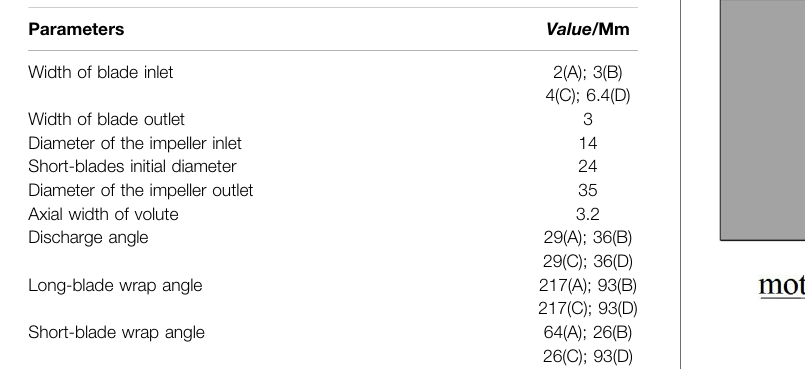
FIGURE 1 | Structure of centrifugal pump.